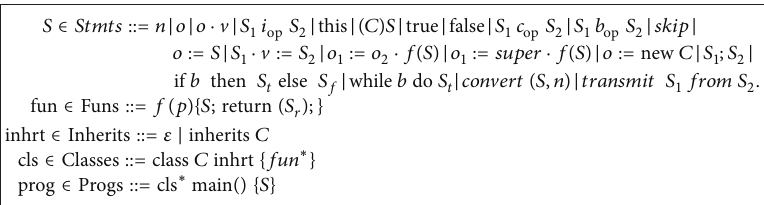
Figure 3: The programming language OODP